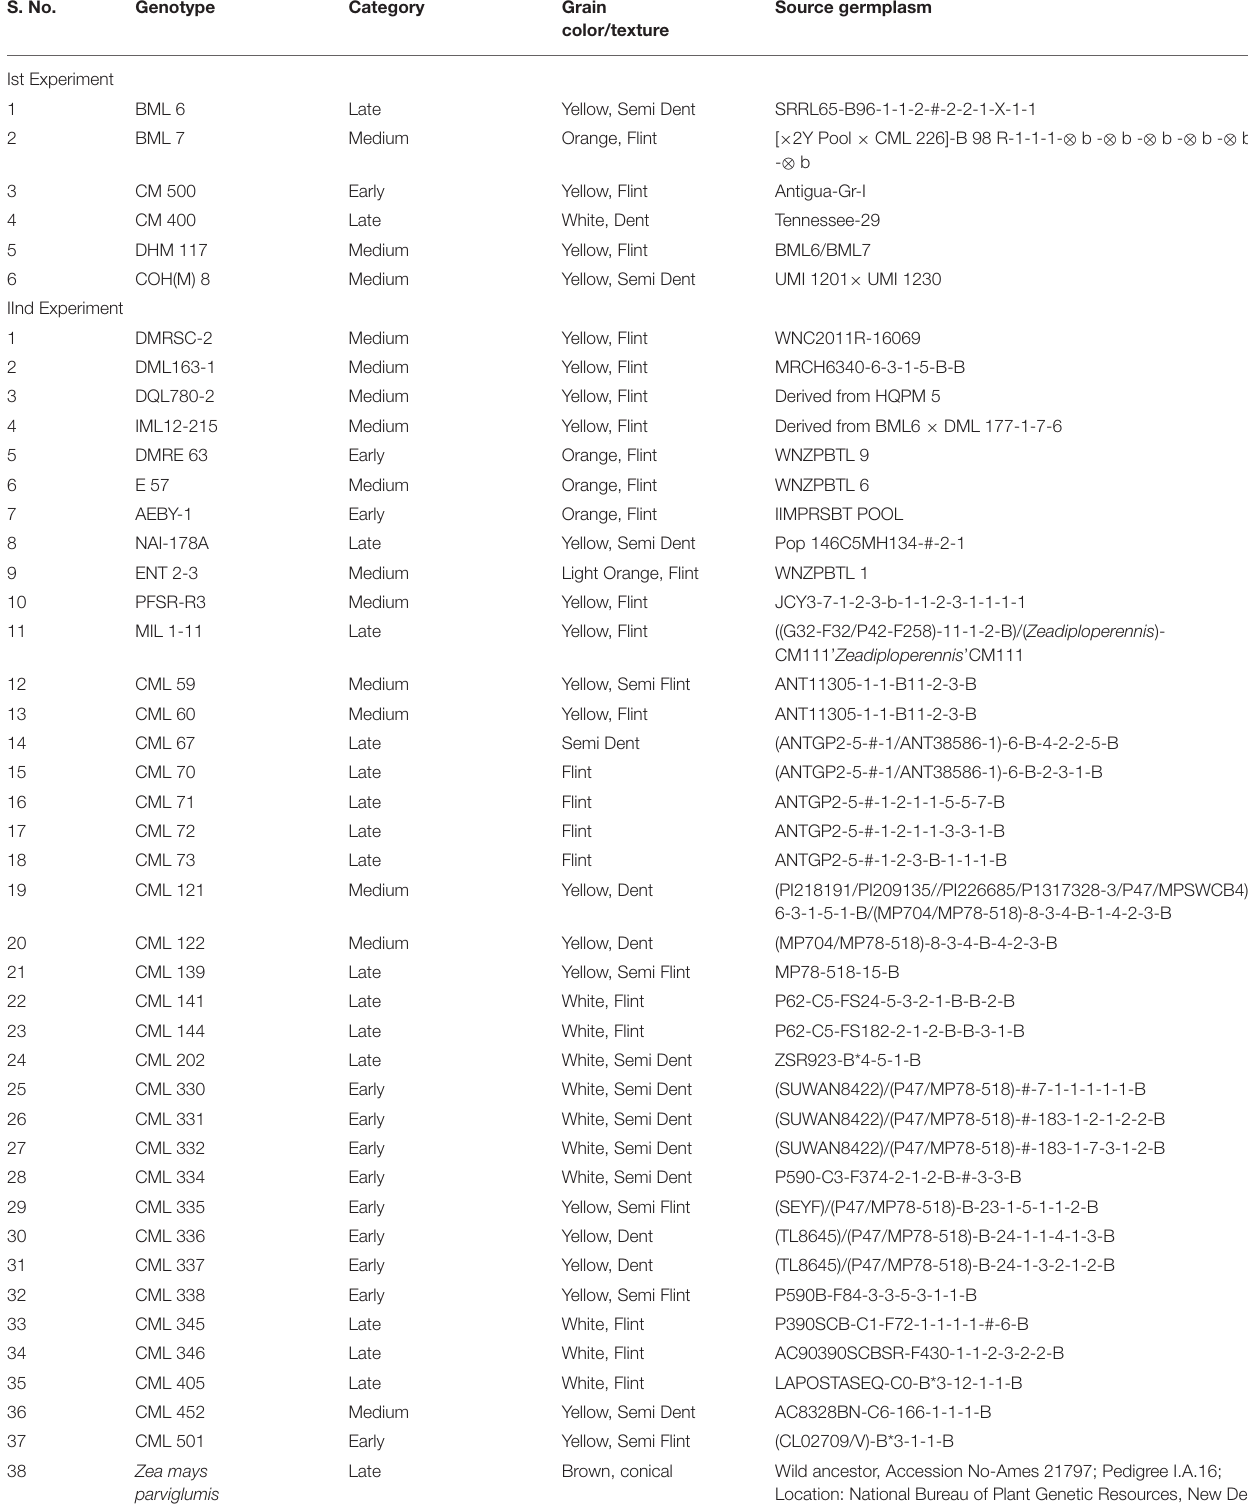
TABLE 1 | Maize genotypes used in the